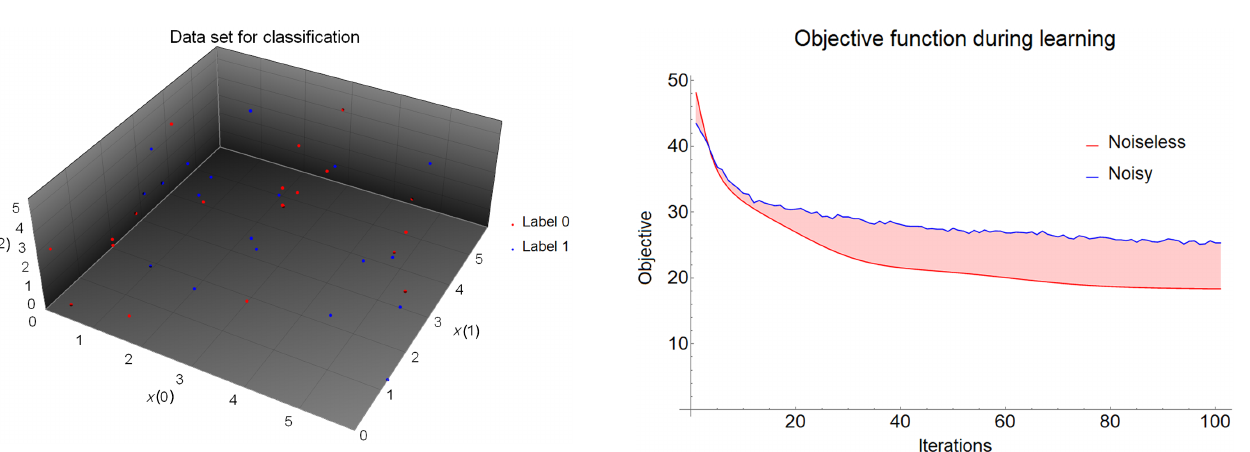
FIG. 5. Convergence of the objective function during gradient descent. Here we compare the ideal and noisy cases, labeled by red or blue,